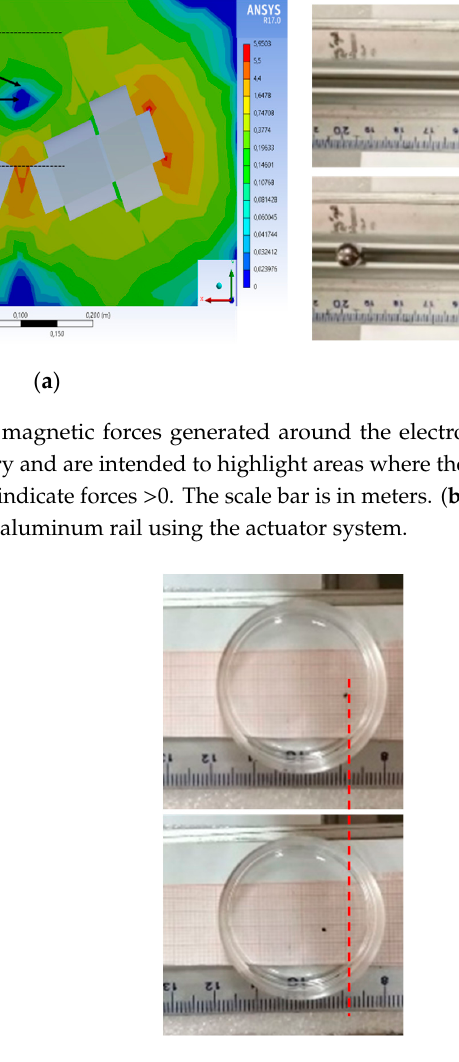
Figure 4. Ferrofluid microdroplet being pushed in oleic acid.